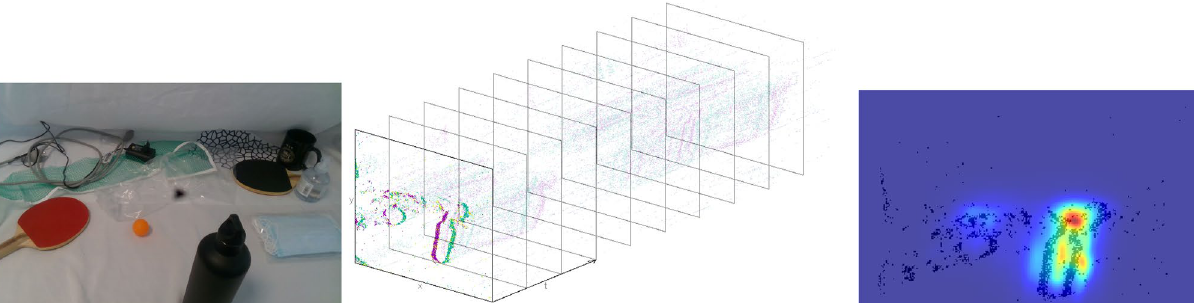
Figure 1. Event-driven proto-object saliency estimation in 3D. Left: Cluttered table top with objects of different sizes and textures placed at varying depths (only for visualisation). Middle: Events produced from the ATIS camera using circular robot eye motion. The event stream is plotted in spatio-temporal coordinates. The green and purple colours represent whether the pixel witnessed a brightness increase or decrease. Events from the stereo cameras serve as input to our model. Right: Saliency map computed using the proposed evProtoDepth model, with the closest object (black bottle) selected. The saliency map is overlaid on the event image generated by accumulating events generated within a 100 ms time window.